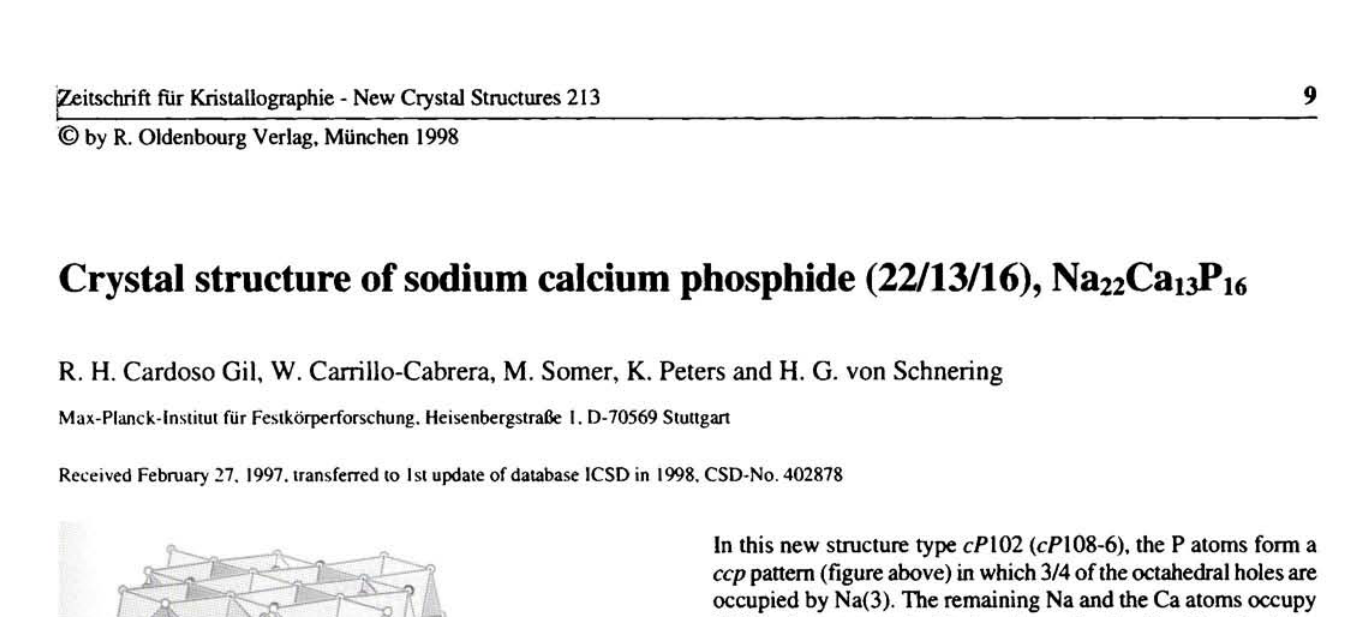
(Table 2) is in agreement with the charge balance rule: